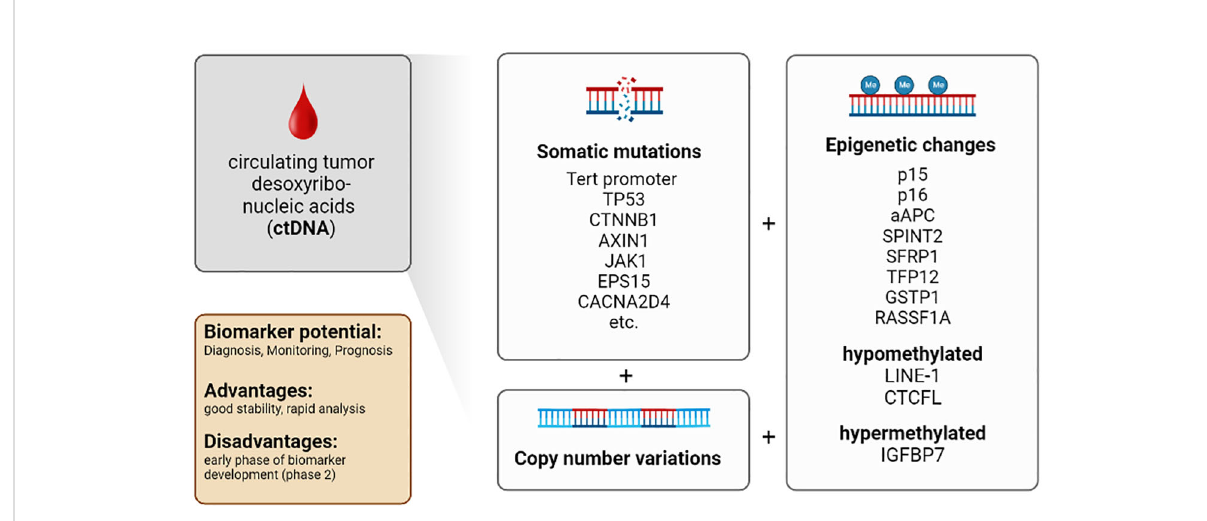
FIGURE 2 Characteristics of the biomarker class circulating tumor desoxyribonucleic acids (ctDNA) in patients with